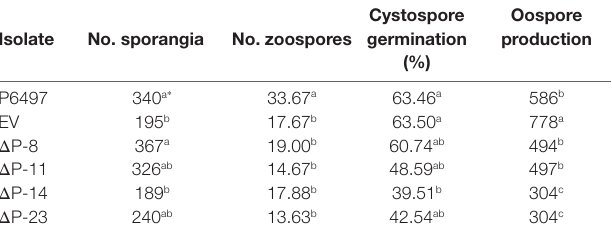
TABLE 1 | Asexual and sexual spores of PsPTL mutants in Phytophthora sojae .